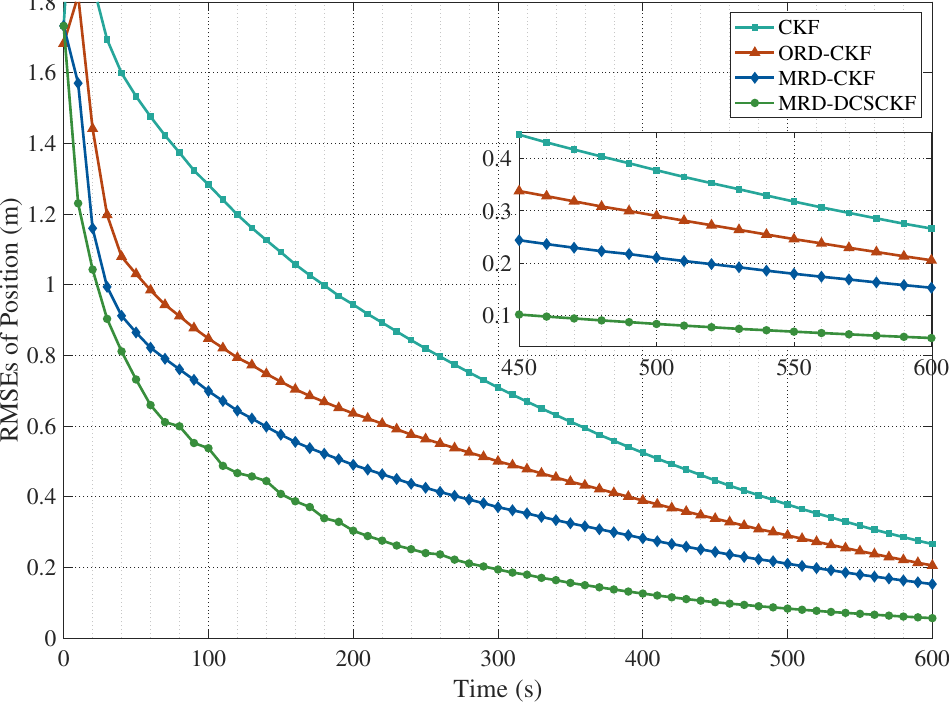
Figure 8. RMSEs of the position with CKF, ORD-CKF, MRD-CKF, and MRD-DCSCKF.